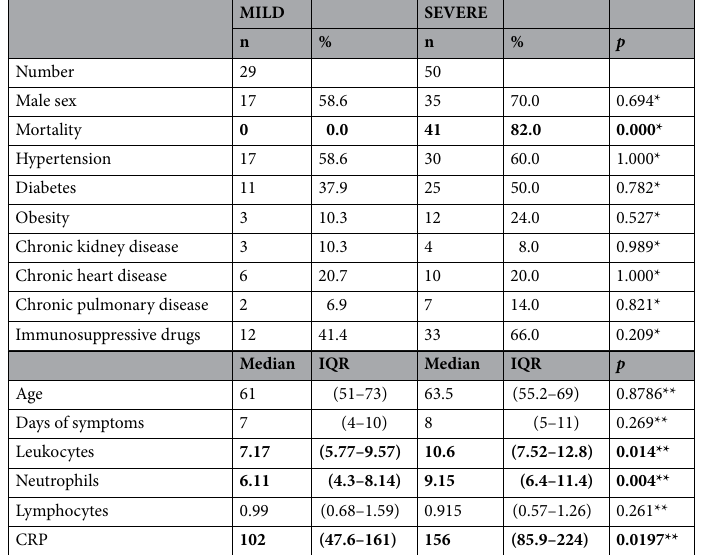
Table 1. Demographic and clinical characteristics of the patients enrolled in the study. Variables are expressed as number (%) or median (interquartile range). Bolded values indicated variables with statistically significant associations (significance level of 0.05). * P values were calculated using the chi-square test in R software (version 4.0.3 for macOS). ** P values were calculated using the nonparametric Mann–Whitney test in R software (version 4.0.3 for macOS), that tests for trend across ordered